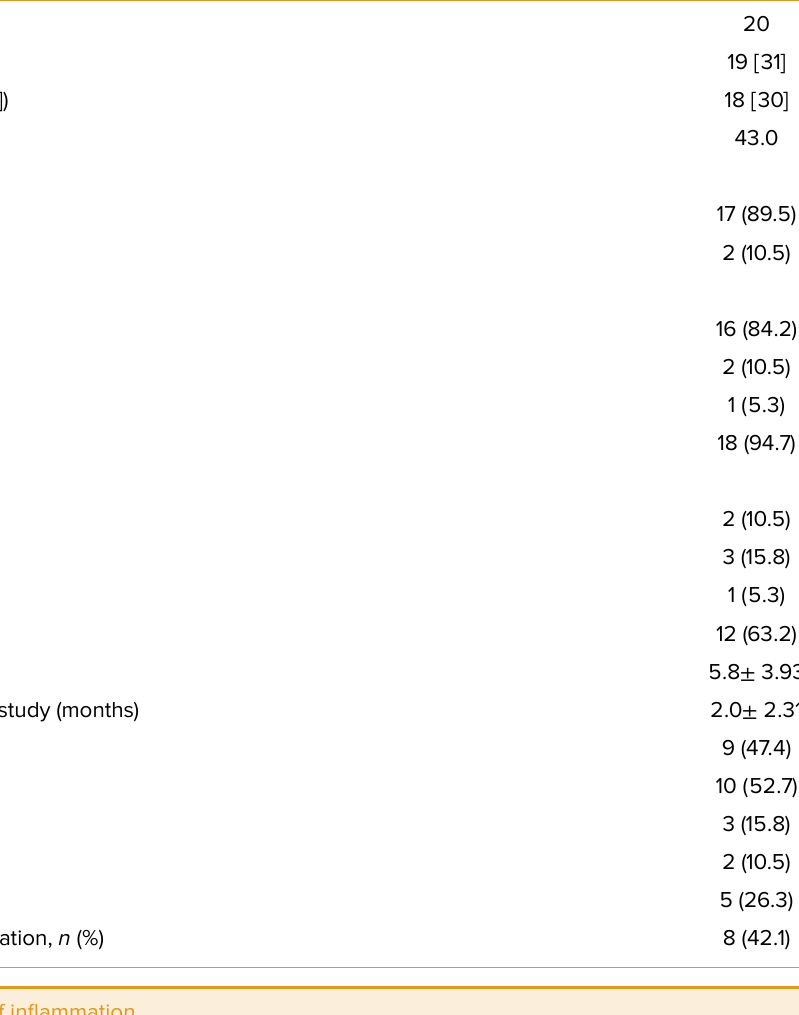
Table 2. Comorbidities and complications of